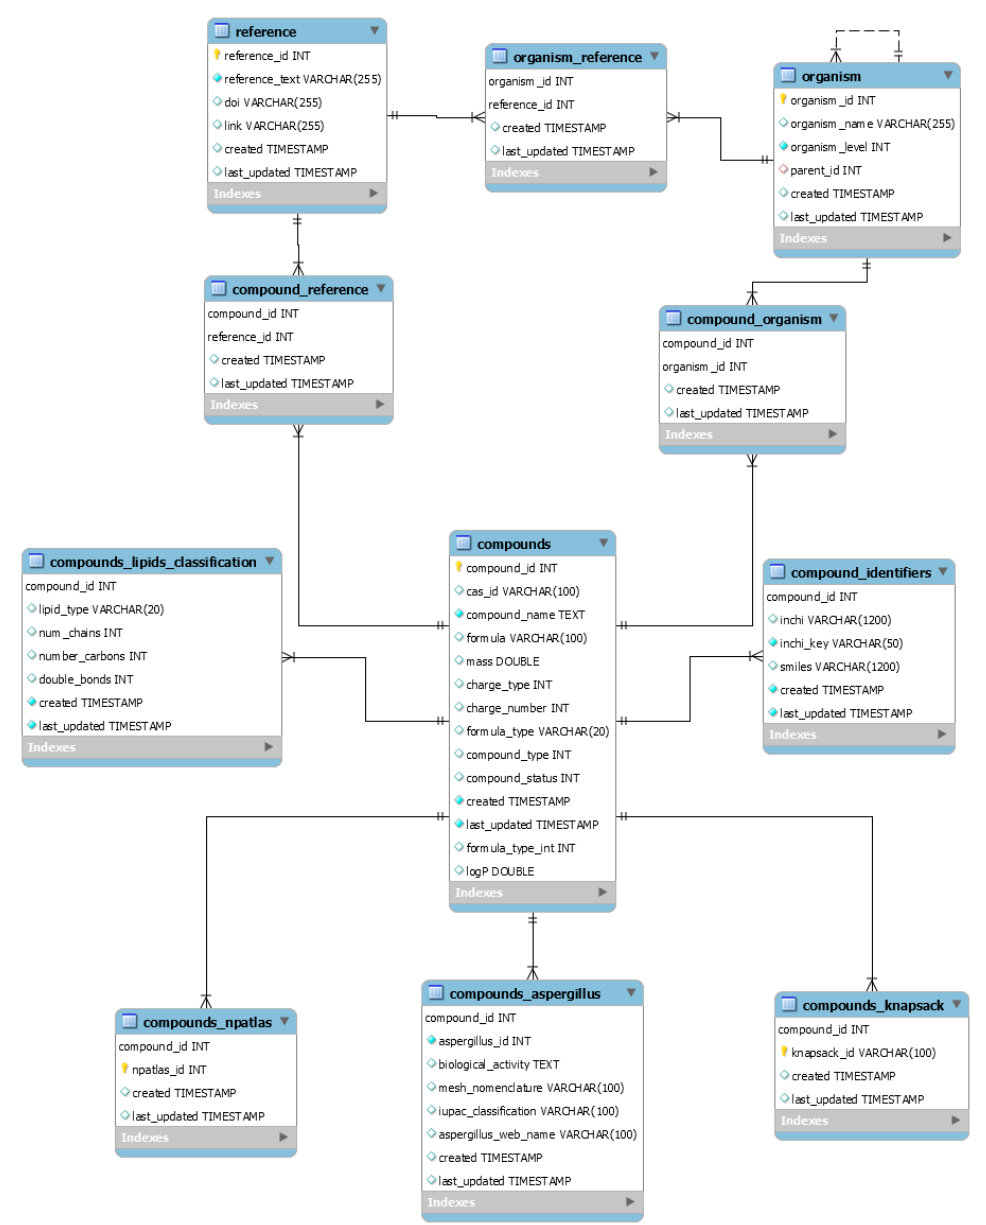
Figure 1. Abbreviated Entity-Relation model for the CMM Aspergillus Database. Full model is available in Supplementary Information, file “SI1_fullERModel.mwb”.